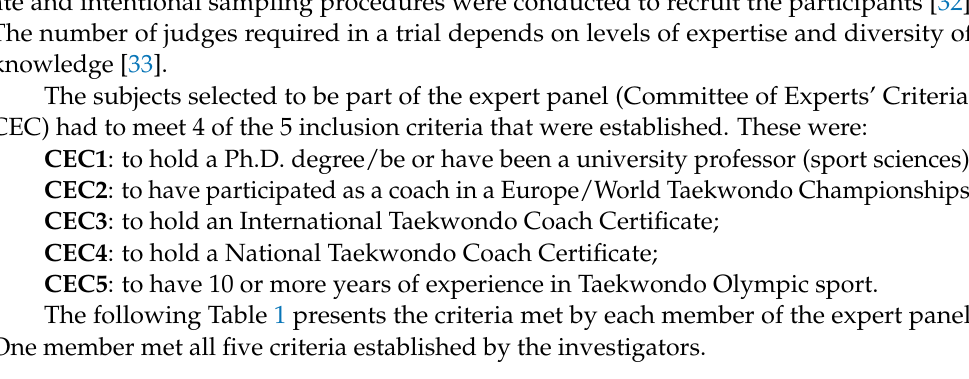
Table 1. Criteria met by each expert panel